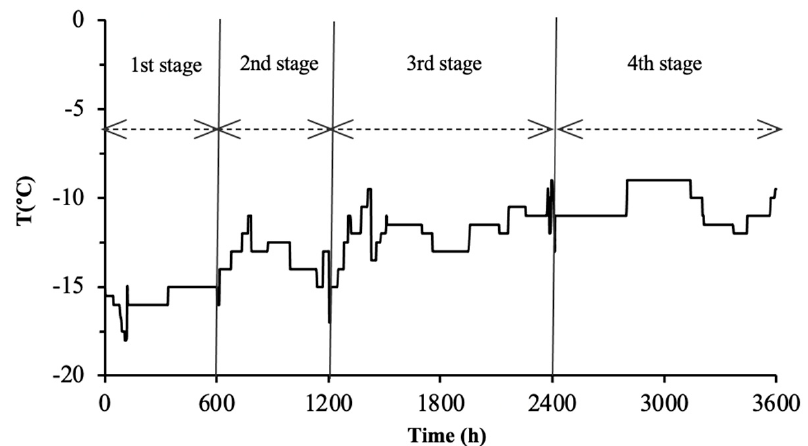
Figure 8. Indicative temperature profile of the distribution of frozen fish in the real chill chain. The total distribution time was 150 days. (1st stage: packing plant storage, 2nd stage: transportation-distribution center, 3rd stage: retail storage, 4th stage: domestic storage). Table 5. Quality deterioration and remaining shelf life (RSL according to sensory scoring (limit = 5 for overall acceptability) of frozen gilthead sea bream fillets, sea bass fillets and yellowfin tuna slices at the end of each stage of the realistic time-temperature profile (Figure 7).